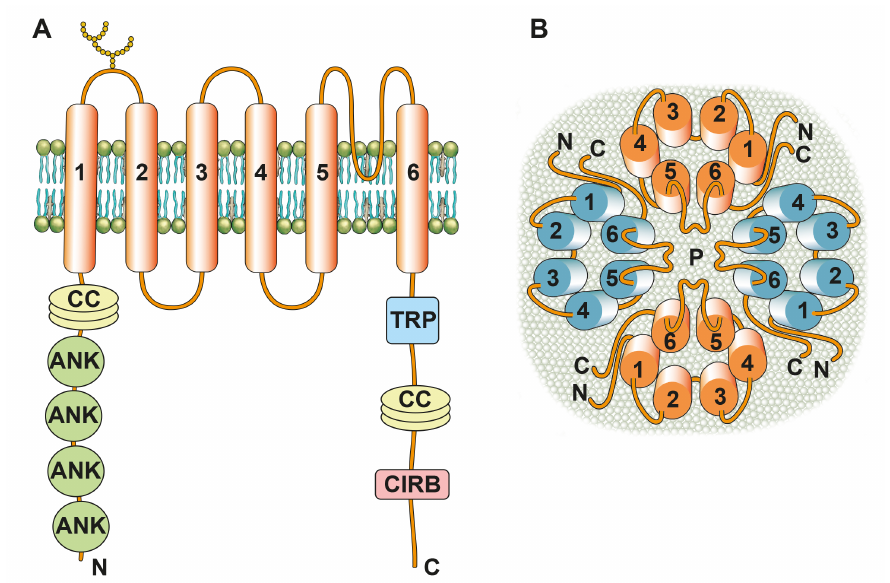
Figure 1. A schematic drawing of the transient receptor potential canonical (TRPC) structure. Six transmembrane segments (numbered 1 to 6) contribute to the formation of a monomer. Both the COOH (C) and NH 2 (N) terminus feature different domains enabling further channel interactions. These include coiled-coil domains (CC), ankyrin domains (ANK), a TRP box (TRP), a calmodulin, and IP 3 -R binding site (CIRB). Different outer potential glycosylation sites exist and differ among the different TRPC entities [19] (( A ); inspired from [20]). Four monomers, from the same or different TRPC entities, assemble to form a homo- or heterotetramer. The loops between the transmembrane segments 5 and 6 contribute to the formation of the cation-permeable pore (P) (( B ); view from